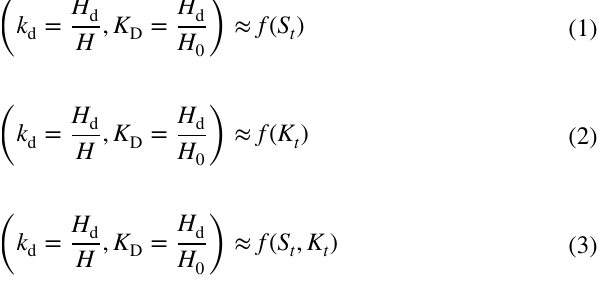
Table 1 Geographic and data records period of Tamanrasset Latitude (°N)